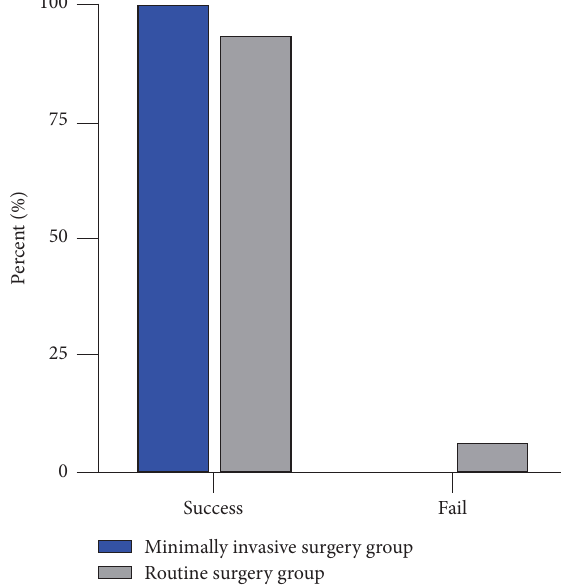
Figure 2: Implant success of two groups of patients. Table 2: Comparison of aesthetic efect evaluation between the two groups after repair.